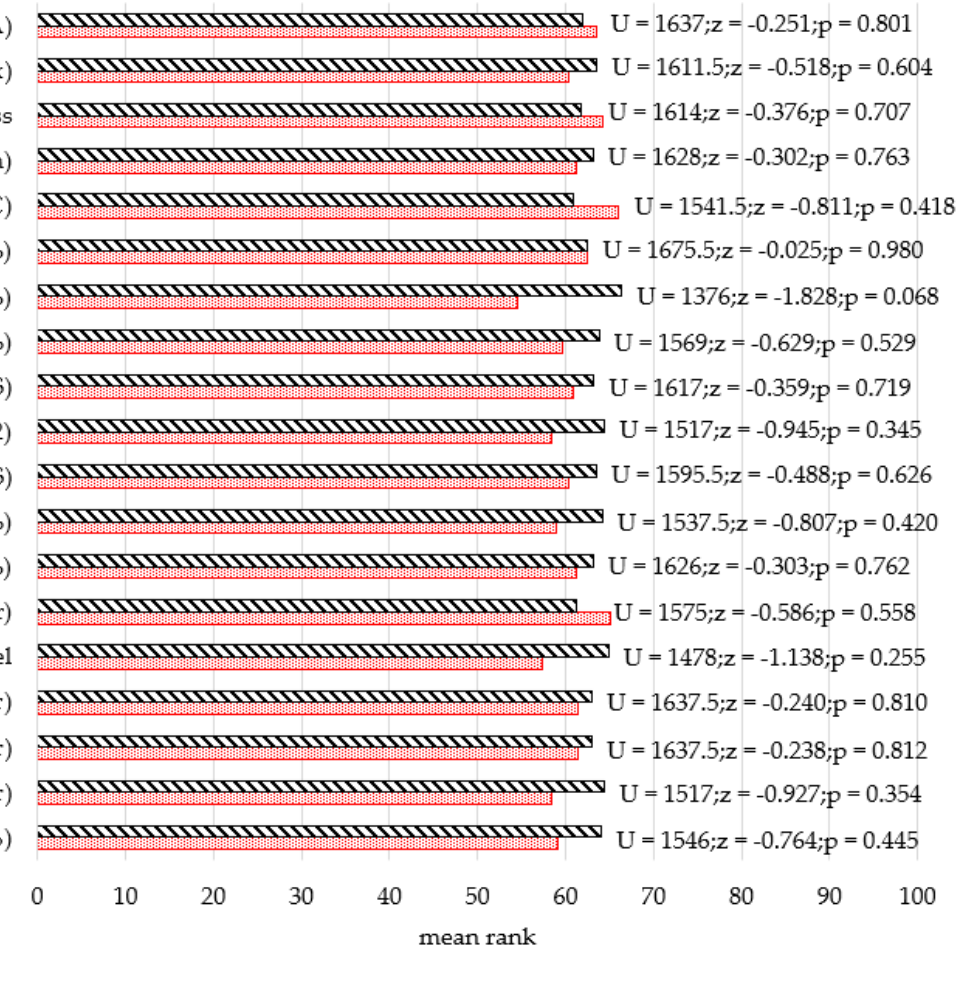
Figure A12. Mann – Whitney U-test results of G6 (academic qualification). Figure A12. Mann–Whitney U-test results of G6 (academic